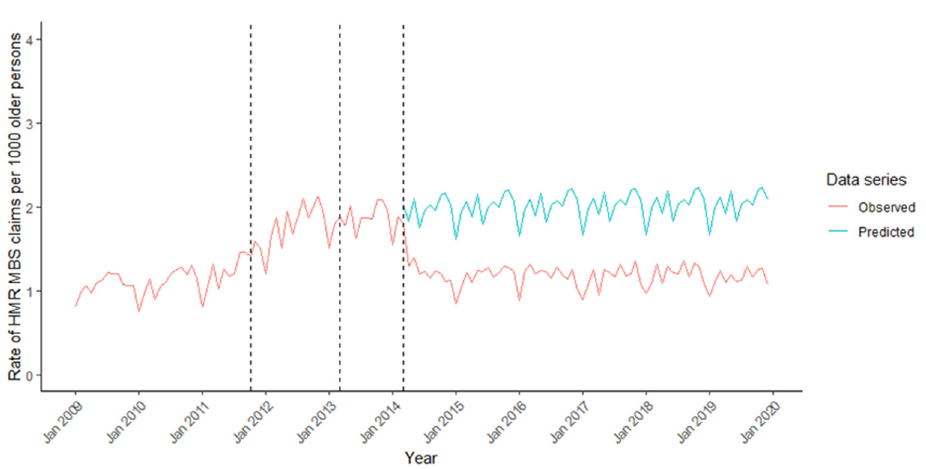
Figure 3. Monthly rate of GP claims for Home Medicines Reviews per 1000 older persons between 2009 and 2019, and counterfactual forecast in the absence of changes to program rules in 2014. Dashed lines indicate dates of program rule changes.